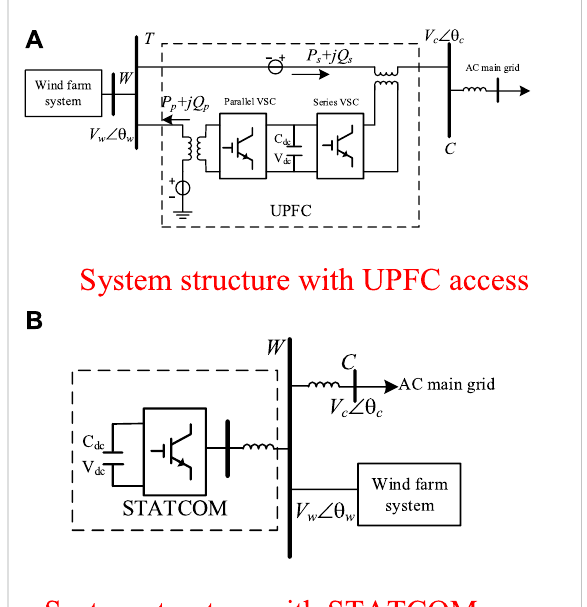
FIGURE 1 Schematic of hybrid power system with VSC. (A) System structure with UPFC access . (B) System structure with STATCOM access